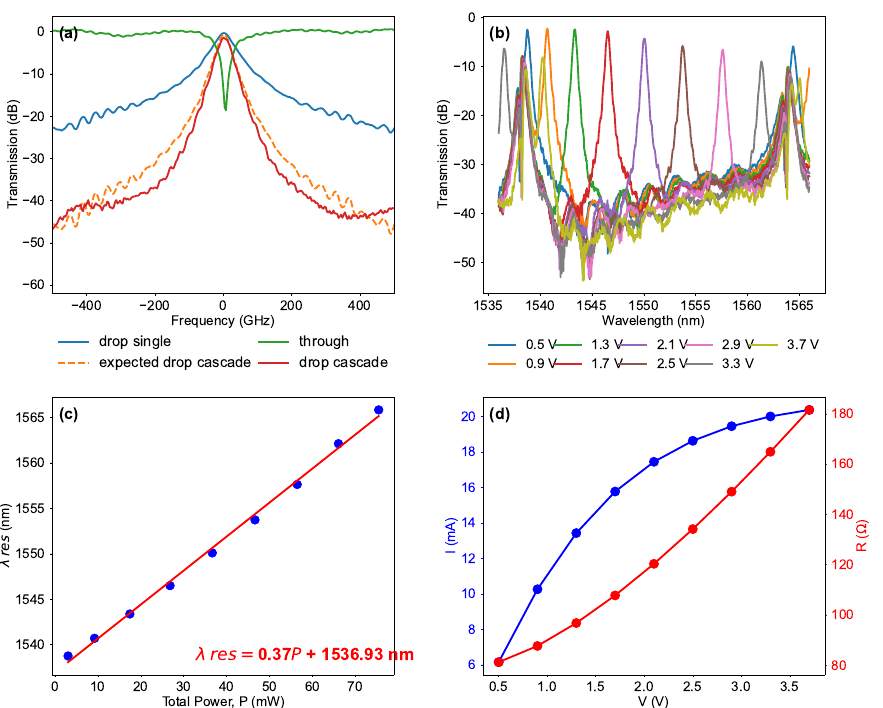
Figure 2. Measurements on cascaded first order ring resonator ( a ) Drop and through transfer spectra of a single first order ring resonator, Expected transfer spectra of cascaded order ring and the best measured cascaded ring, ( b ) Tuning curve of cascaded ring in a unit cell arrangement where bias is applied to only one ring, ( c ) Full FSR tuning is demonstrated. The ring tunes by 27.06 nm ( > FSR = 25.6 nm) with power efficiency of 0.37 nm/mW for two rings. ( d ) I-V and R-V curves for the cascaded ring resonators. Nonlinear dependence of R vs. V is